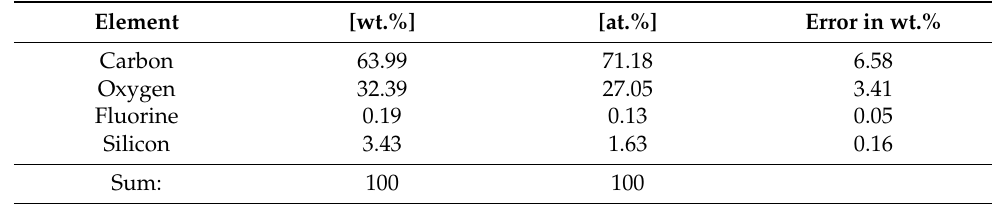
Figure 2. EDX map of FSNP-treated (FSNP1.0) pine wood in tangential section. ( a ) SE image of an FSNP-treated earlywood tracheid cell wall surface. ( b ) Distribution of Si and F elements on the same surface, combined with SE image. Red color indicates presence of fluorine, yellow color indicates presence of silica. Table 2. Quantitative elemental composition of the FSNP-treated (FSNP1.0) Scots pine earlywood tracheid cell wall surface shown in Figure 2.